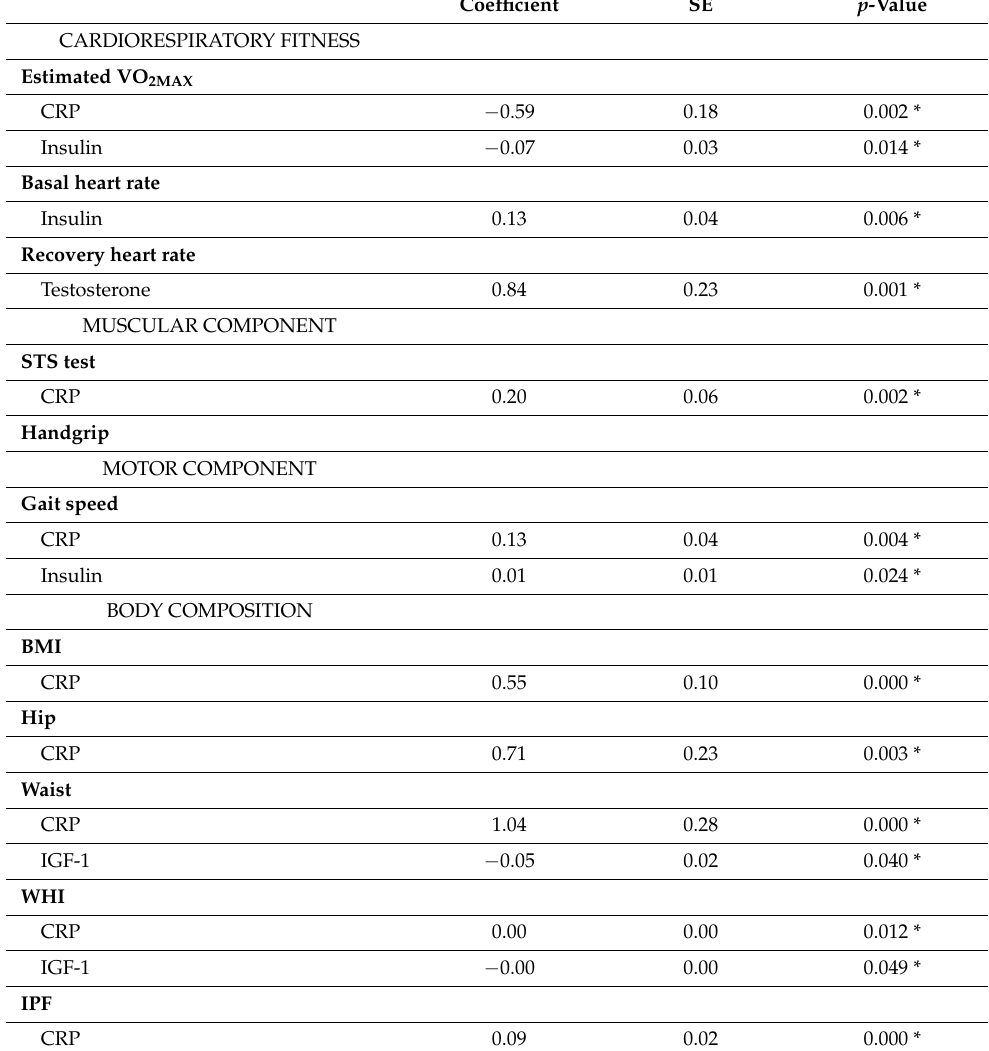
Table 3. Regression coefficients. Biomarkers and PF